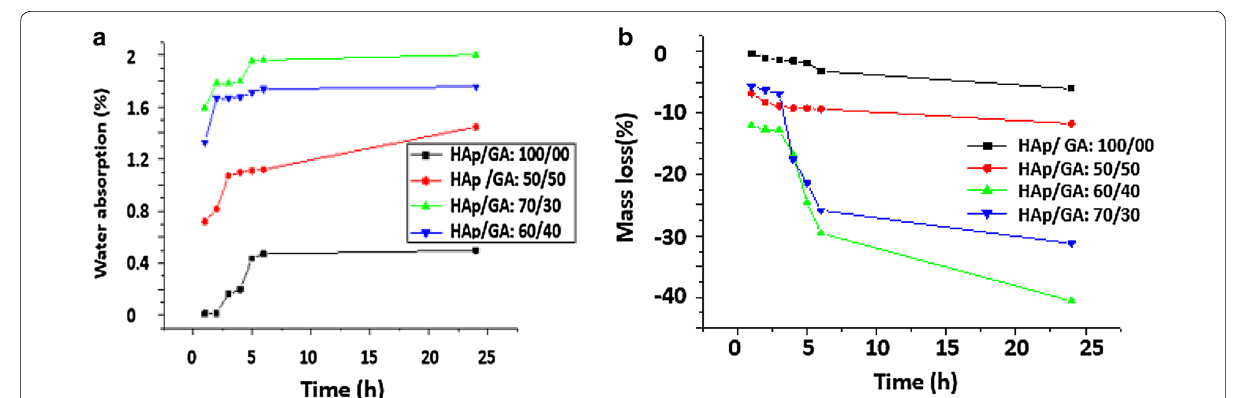
Fig. 6 The rate of weight loss ( a ) and water absorption ( b ) as a function of soaking